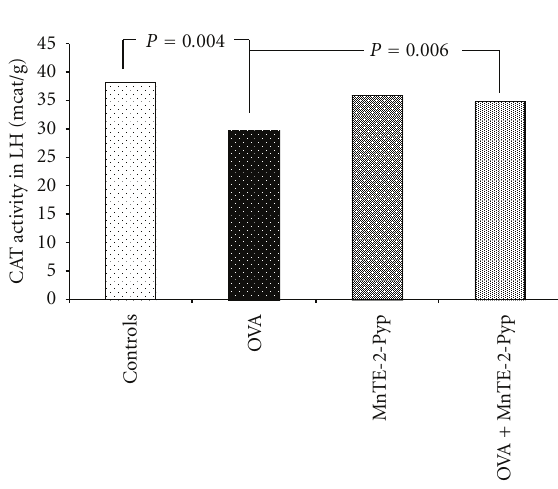
Figure 2: Activity of catalase in lung homogenate. Each point represents the median for six mice.